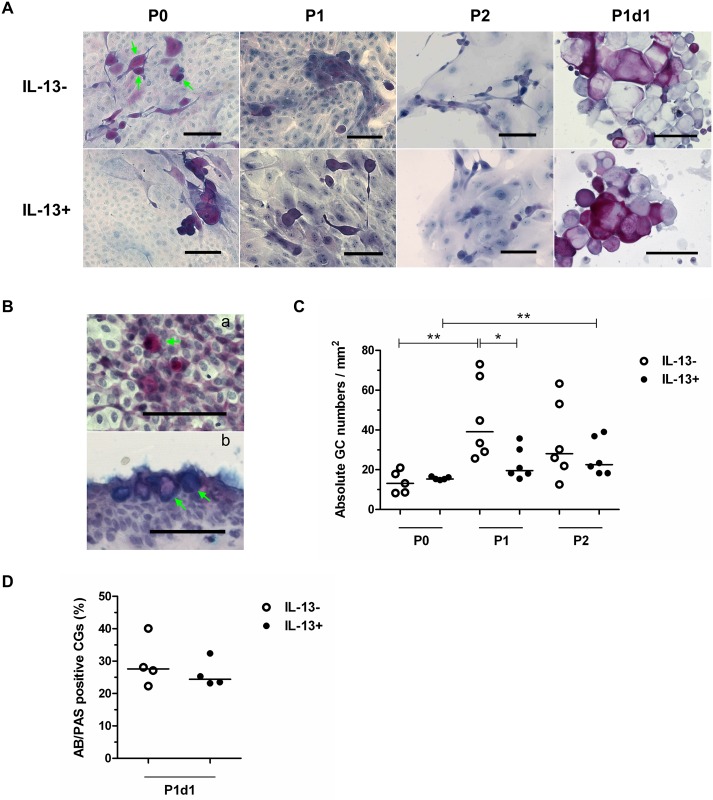
AB/PAS staining of GCs in IL-13- or IL-13+ cell cultures and P1d1 subpopulation.(A) P0 cells originating from limbal explants, P1 and P2 cells (all fixed at the end of cultivation), and the unattached GC-enriched subpopulation (P1d1, harvested on day 1 after passage of primary cells) were analyzed by AB/PAS staining. Green arrows indicate examples of GCs. (B) AB/PAS-positive GCs on the surface of the conjunctiva (impression cytology) (a) and on pterygium cryosections (b) were used as a positive control. Green arrows indicate examples of GCs. (C) Distribution of absolute numbers of AB/PAS-positive GCs in individual groups presented in a vertical scatter plot graph with line indicating median. (D) Distribution of percentages of AB/PAS-positive GCs in individual groups of P1d1 subpopulation presented in a vertical scatter plot graph with line indicating median. *P < 0.05, **P ≤ 0.01. Scale bars: 100 μm.